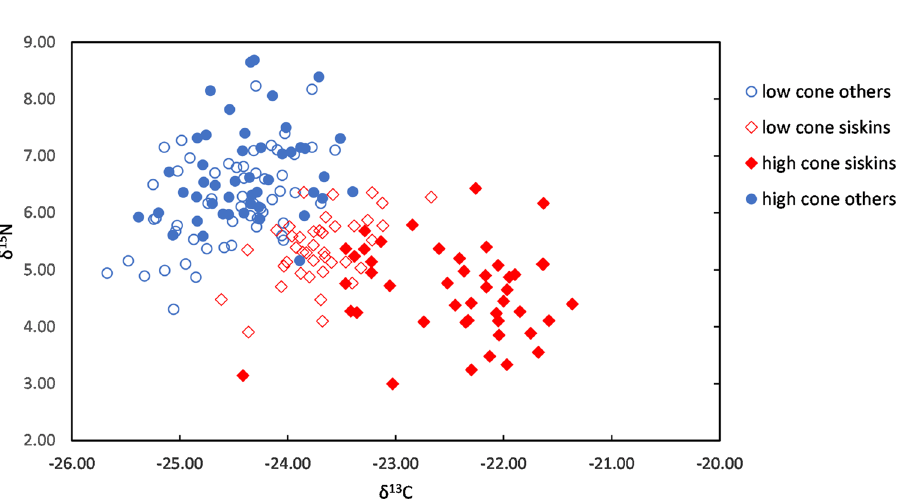
Figure 7. Carbon–nitrogen isotope biplot of each tested sample. Siskins in red, all other birds in blue. High cone crop (score ≥ 6) years are filled symbols low cone crop (score < 6) years are open